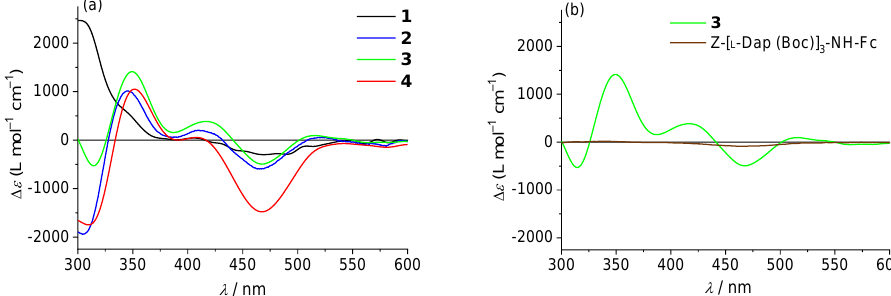
Figure 11. CD spectra in CH 2 Cl 2 solutions of compounds ( a ) 1 – 4 ; ( b ) 3 and Z -[ L -Dap(Boc)] 3 –NH–Fc; c = 1.0 mM.